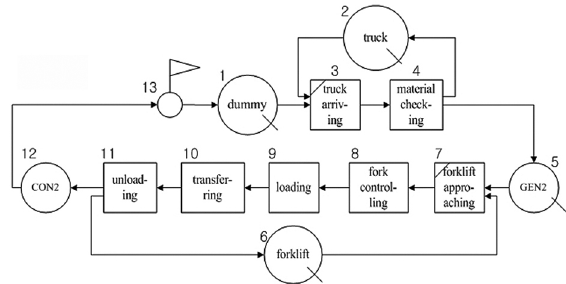
Fig. 2. Initial simulation model for the unloading process